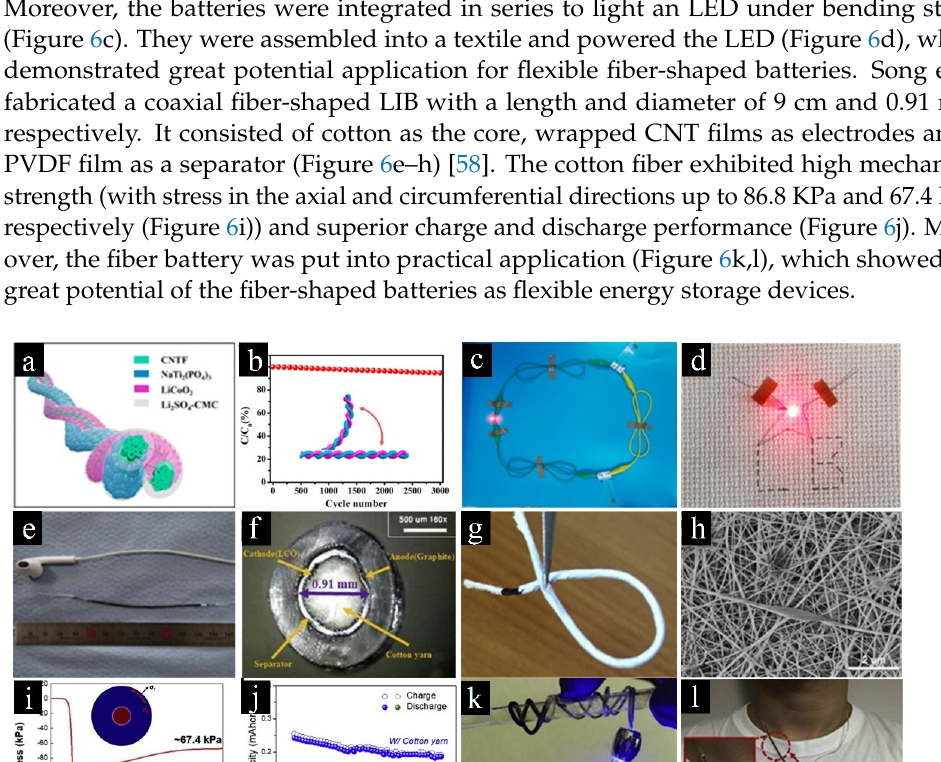
Table 1. The performance of reported 1D fiber-shaped FLIBs. Carbon-Based Electrodes